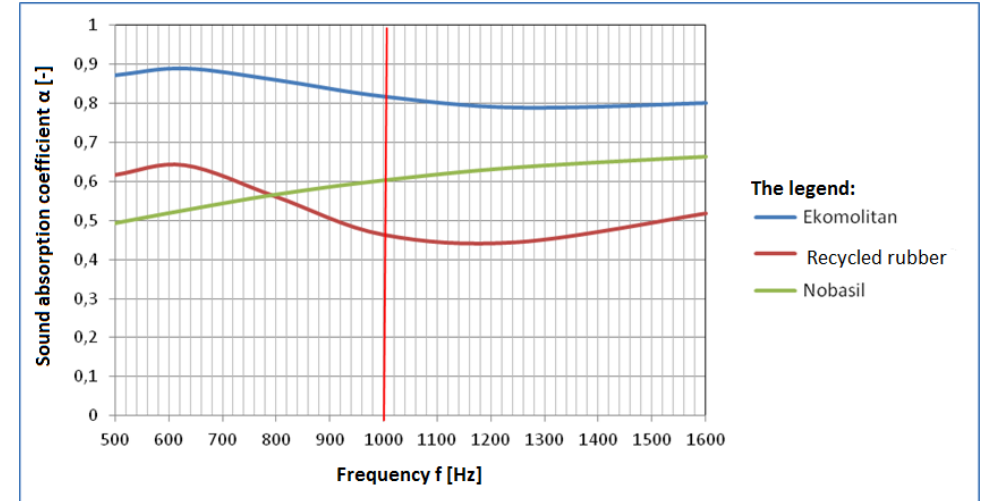
Figure 10. Sound absorption coefficient α (material thickness—60 mm).